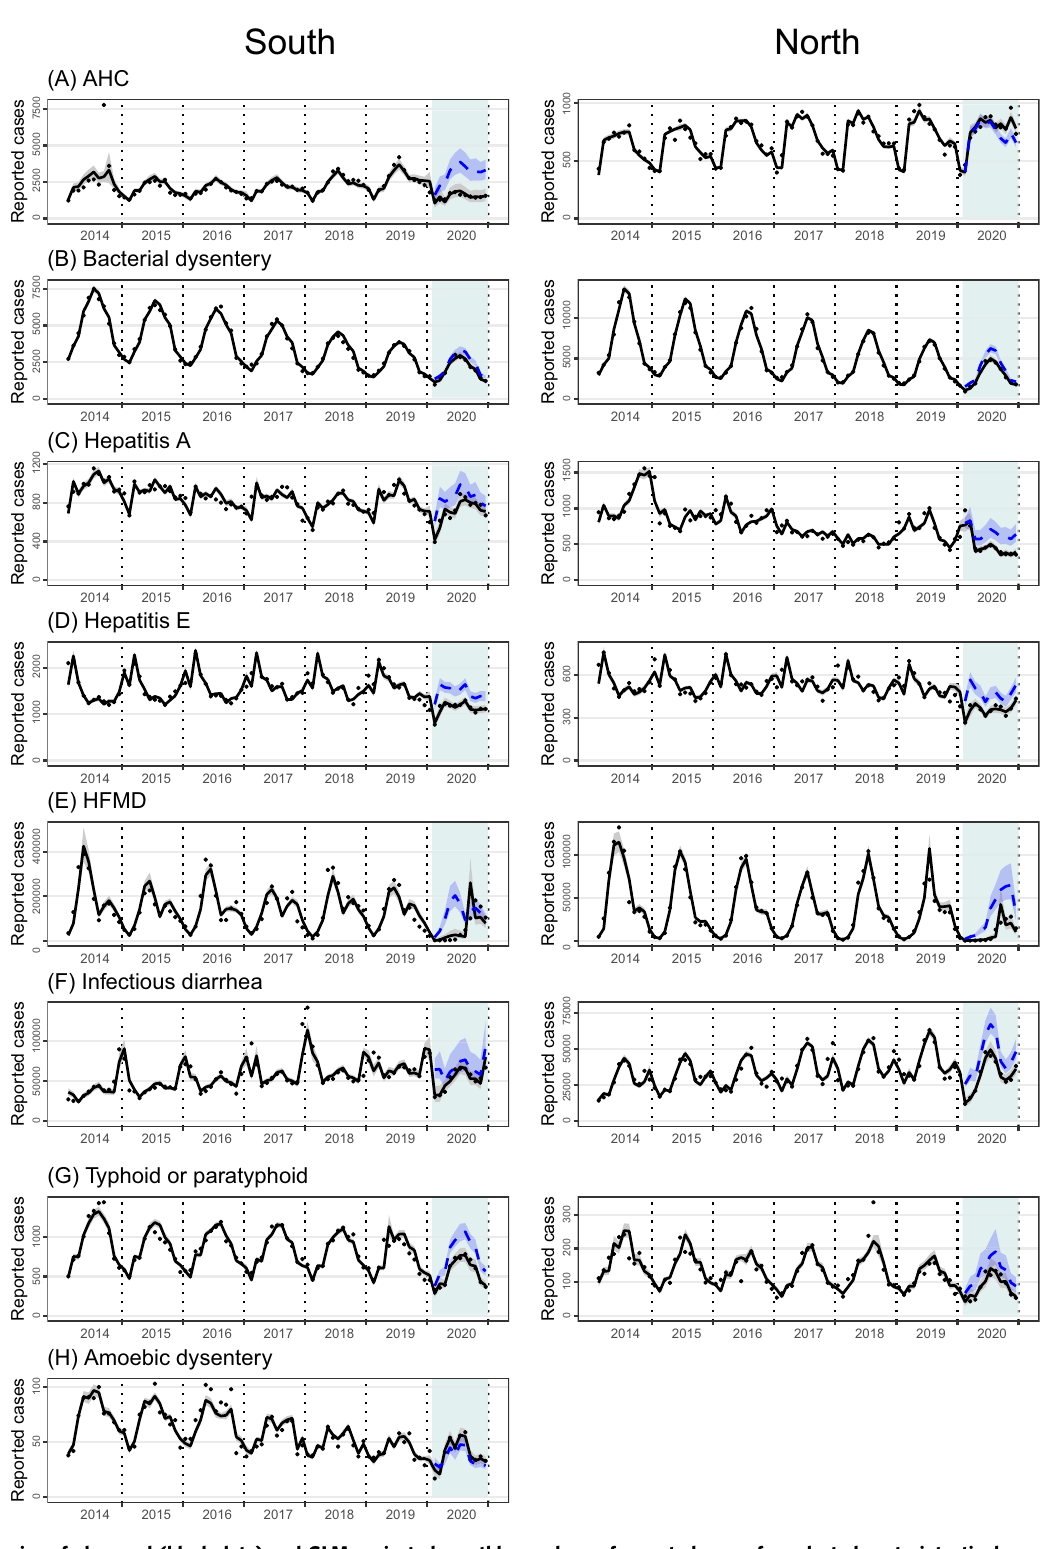
Fig. 3 Time series of observed (black dots) and GLM-projected monthly numbers of reported cases for selected gastrointestinal or enteroviral diseases. A Acute hemorrhagic conjunctivitis, B bacterial dysentery, C hepatitis A, D hepatitis E, E hand, foot, and mouth disease, F infectious diarrhea, G typhoid or paratyphoid, and H amebic dysentery. The model-projected trajectories are shown for both with (black solid) and without (blue dash, 2020 only) nonpharmaceutical interventions. Intervention phases II – IV (Feb – Dec) in 2020 are colored light blue. For the counterfactual trajectory without